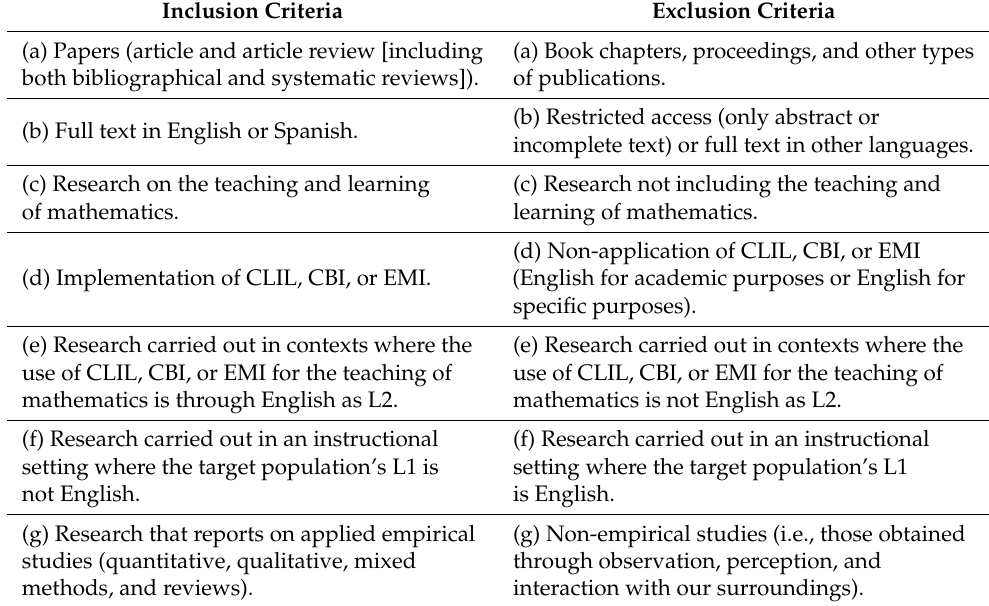
Table 2. Inclusion/exclusion